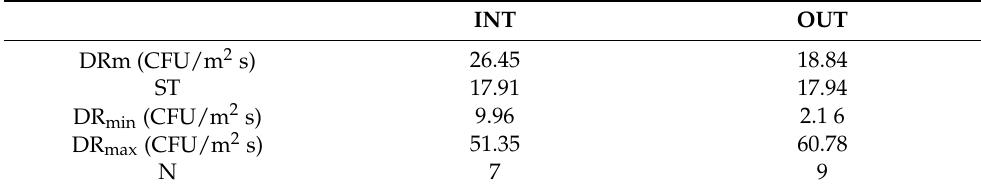
Table 7. Mean total bacteria deposition rate (DRm, CFU/m 2 s) standard deviation (ST), minimum total bacteria deposition rate (DR min , CFU/m 2 s), maximum total bacteria deposition rate (DR max , CFU/m 2 s), number of samples (N). Sampling date: 5 April 2022, sampling site: within the pens (INT), downwind the pens